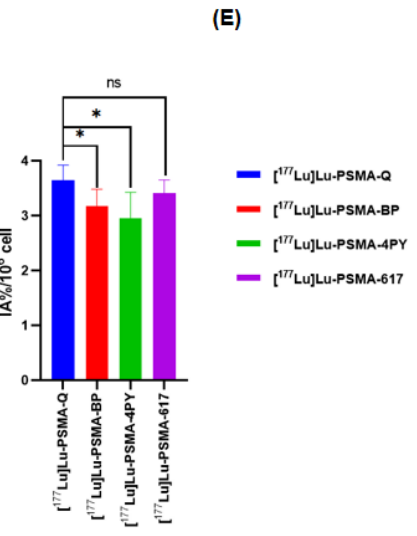
Figure 3. Cell uptake of [ 177 Lu]Lu-PSMA-BP ( A ), [ 177 Lu]Lu-PSMA-Q ( B ), [ 177 Lu]Lu-PSMA-4PY ( C ) and [ 177 Lu]Lu-PSMA-617 ( D ) in 22Rv1 and PC-3 cells. Comparison of cell uptake of [ 68 Ga]Ga-PSMA-Q, [ 68 Ga]Ga-PSMA-11, and [ 68 Ga]Ga-PSMA-617 in 22Rv1 cells at 24 h ( E ). (*: p < 0.05, ****: p < 0.0001, ns: p > 0.05, block: 2-PMPA).